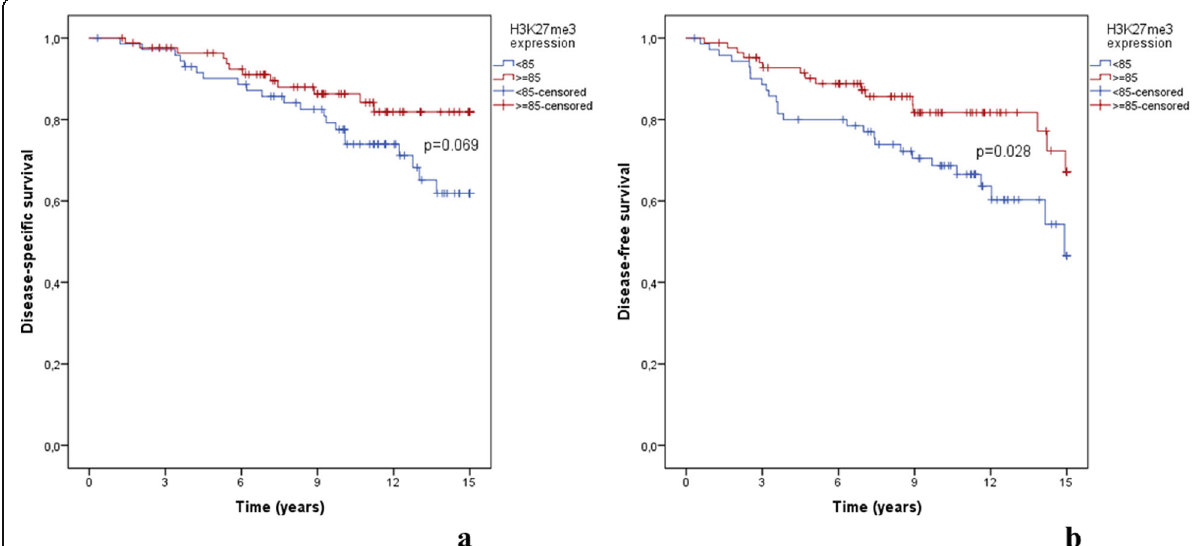
Fig. 2 Kaplan – Meier analysis (censored at 15 years of follow-up) for a disease-specific survival and b disease-free survival, both according to H3K27me3 expression using 85% cut-off